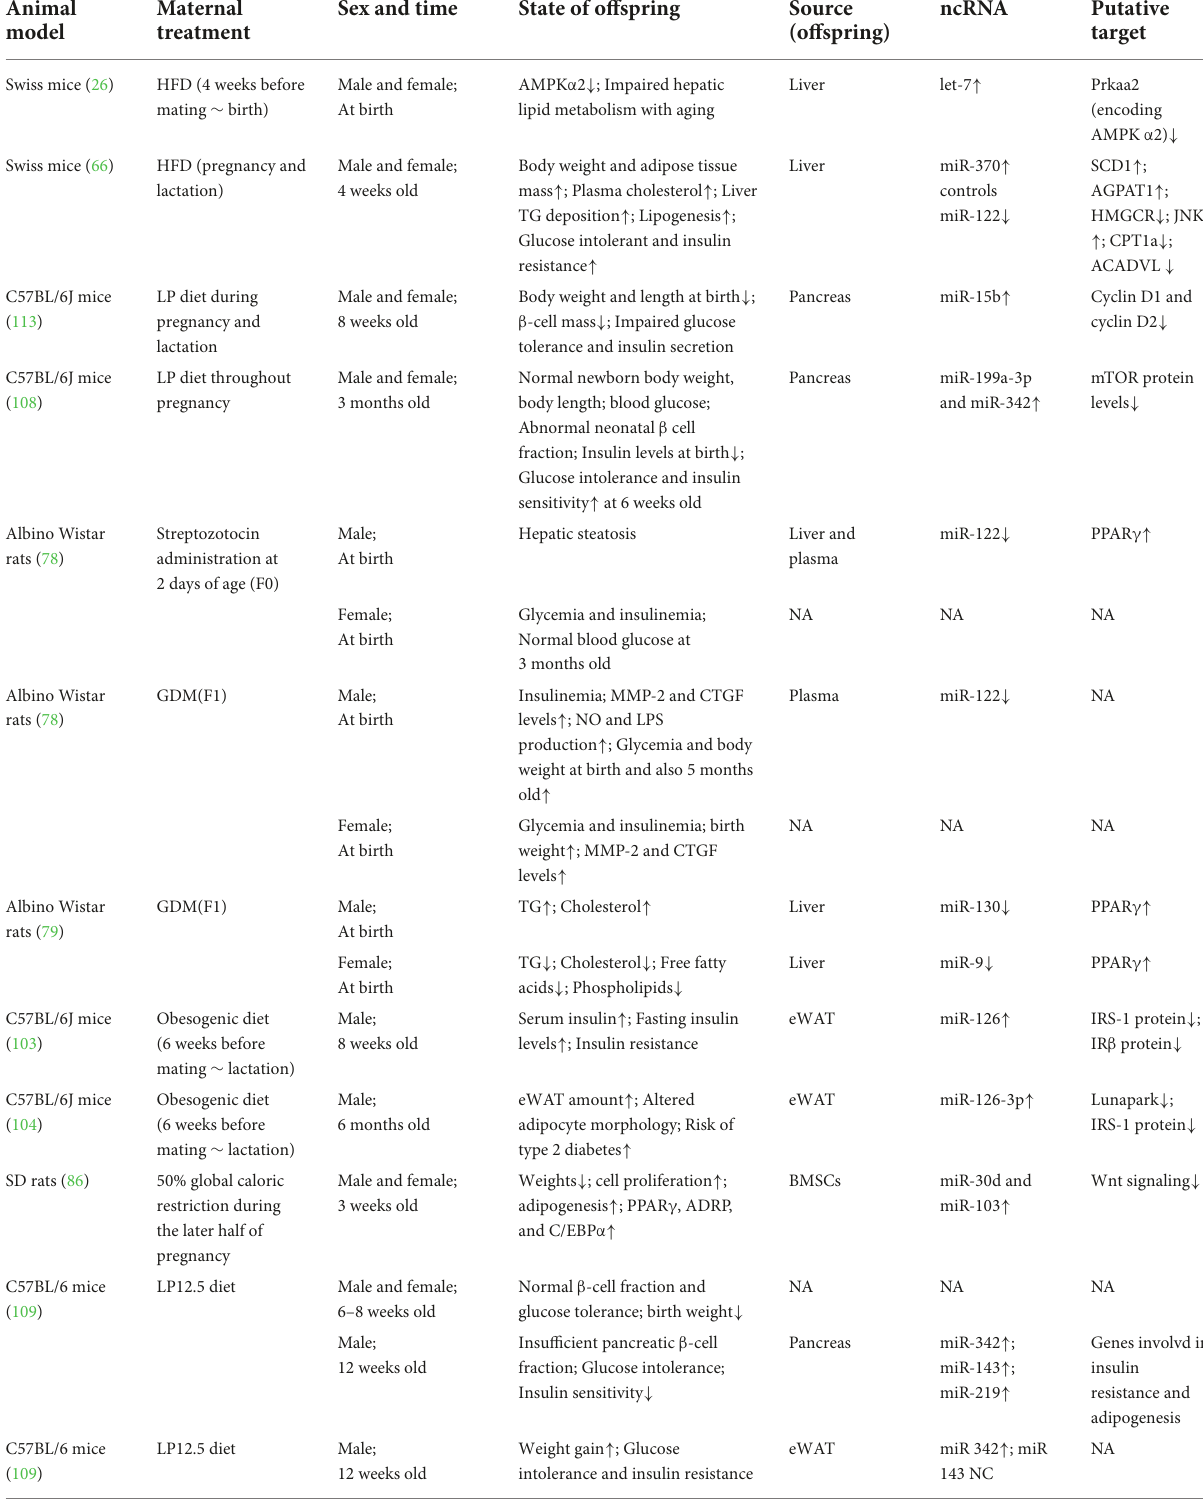
TABLE 1 The role and changes of ncRNA in animal adverse intrauterine environment and late metabolic disorders. Animal